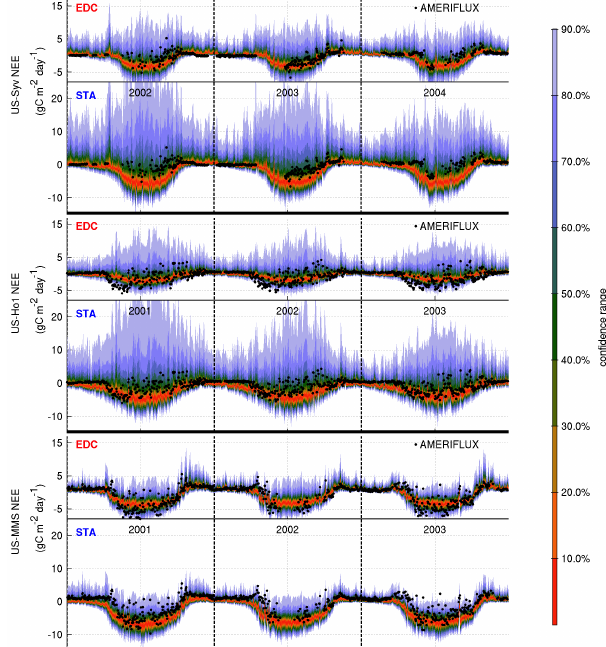
Figure 4. DALEC2 daily NEE ensemble estimates at three Amer- iFlux sites: Sylvania Wilderness (US-Syv, mixed forest, top two rows), Howland Forest (US-Ho1, evergreen needleleaf, middle two rows), and Morgan Monroe State Forest (US-MMS, deciduous broadleaf, bottom two rows). For each site the DALEC2( xa EDC ) and the DALEC2( xa STA ) ensemble confidence intervals are de- noted as EDC and STA, respectively. The DALEC2 analyses – based on MODIS LAI retrievals, HWSD soil organic carbon es- timates and ERA interim meteorological drivers – are completely independent from all AmeriFlux site